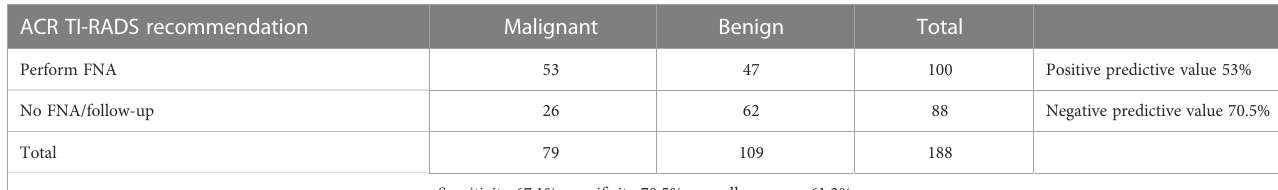
TABLE 6 Assessment of the overall ACR TI-RADS